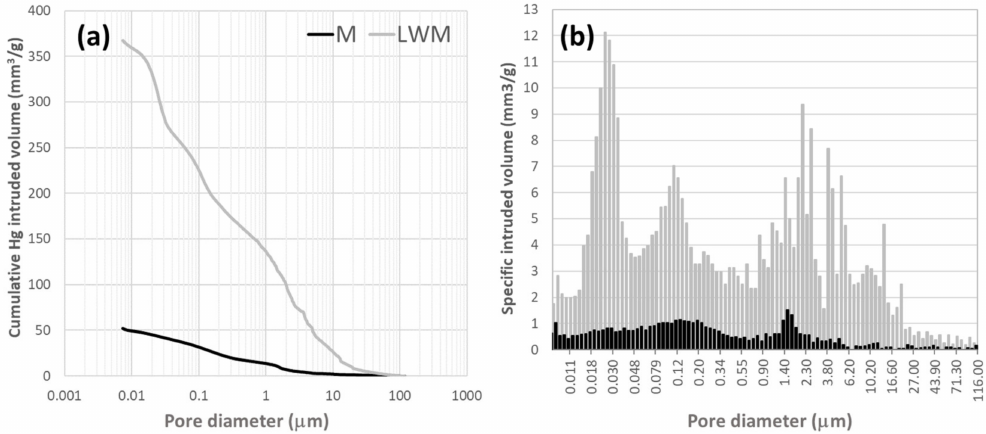
Figure 3. Pore size distribution of LWM and M samples measured by mercury intrusion porosimetry: ( a ) cumulative specific Hg intruded volume versus pore size; ( b ) histograms representing the specific intruded volume in the pore size ranges.